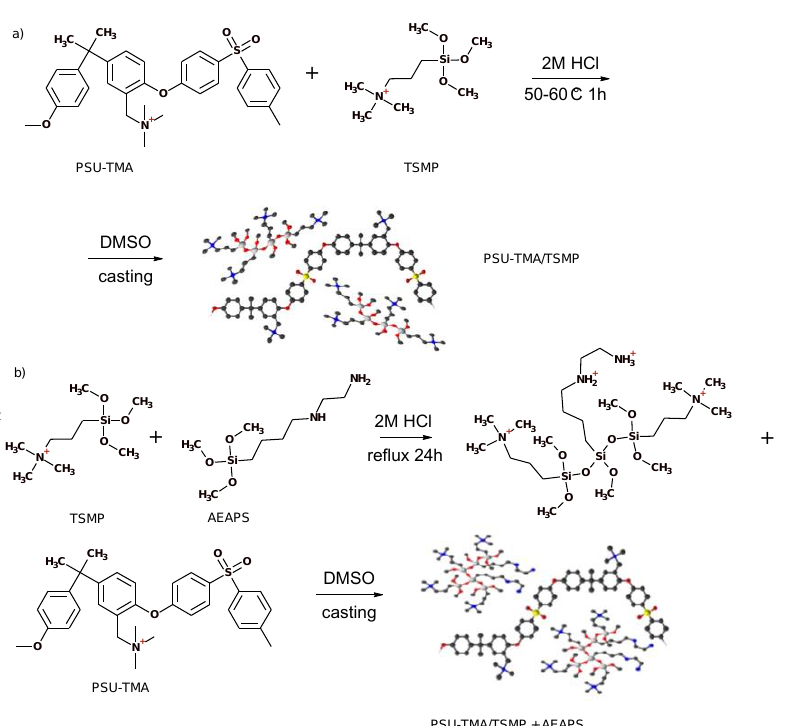
Figure 7. Synthesis routes for hybrid membranes by ( a ) in-situ and ( b ) ex-situ sol–gel techniques [90].